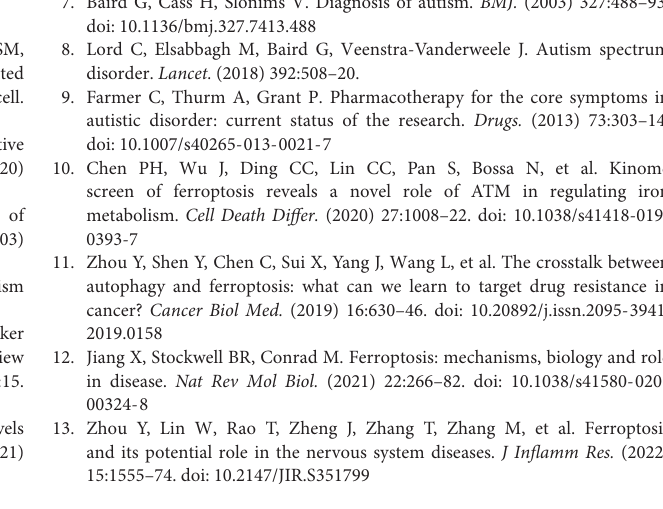
Supplementary Figure 1 | Venn diagram of key FRGs. Supplementary Figure 2 | The correlation between key FRG